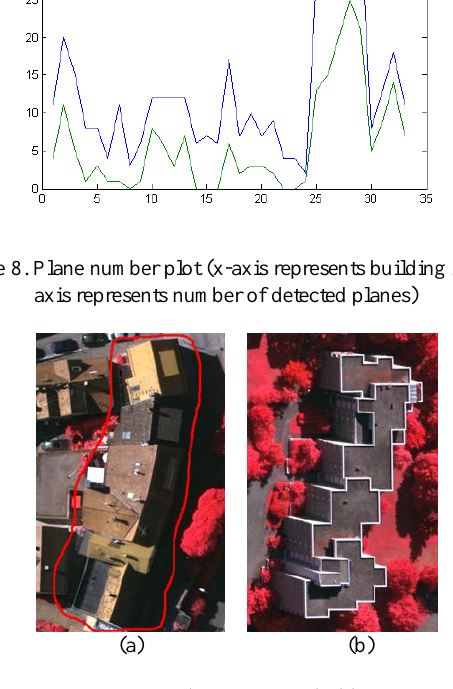
Figure 9. Building images (Cramer, 2010). (a) Dense buildings in area 1. (b) high-rising residential building in area